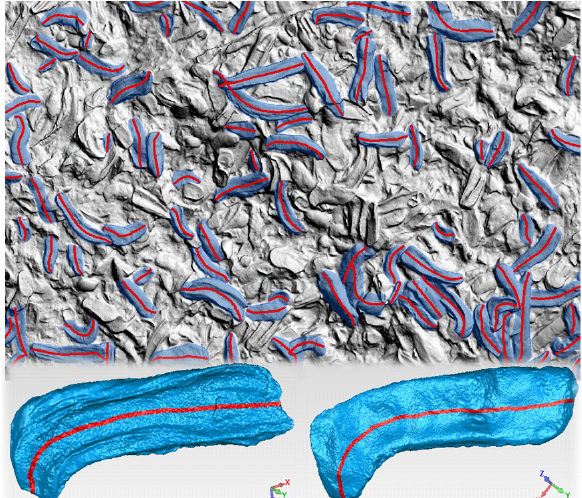
Figure 4. Top row: Shaded DSM (2 m by 3 m) overlapped with extracted 2D lines (red) of complete Crassostrea gryphoides oysters (blue); Bottom row : visualization of fitted 3D central line on shell pair mesh model (convex down left shell and convex up right